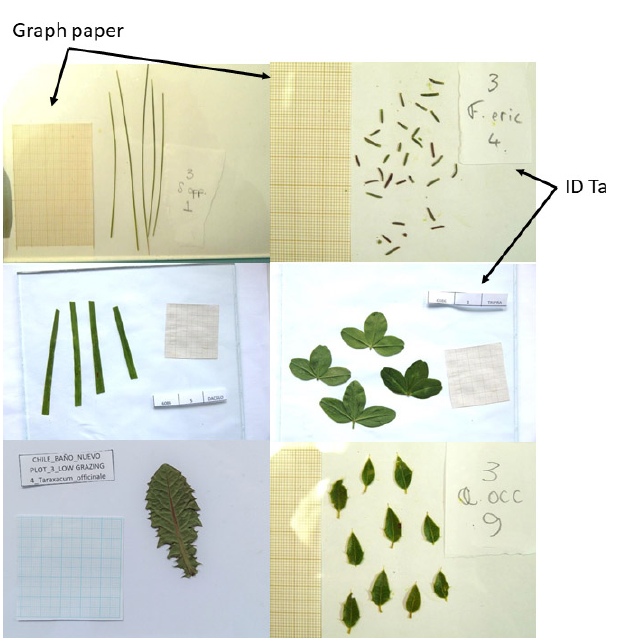
Figure 12. Examples of pictures taken for leaf area measurements. Photographs by Nicolas